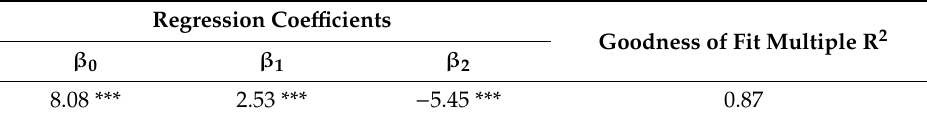
Table 3. Summary statistics for the linear response function fit to the EAD, mean, and standard deviation, ln ( EAD ) = β 0 + β 1 µ + β 2 1 σ .